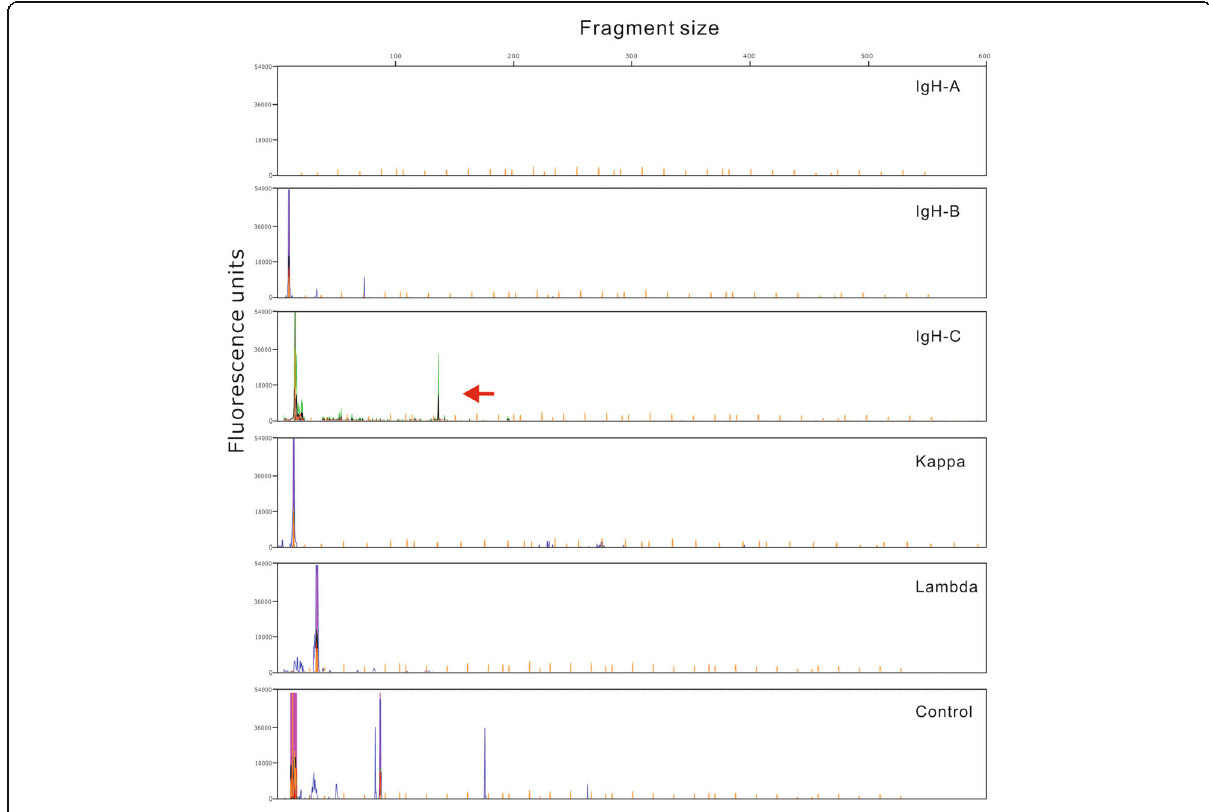
Fig. 5 Molecular testing for gene rearrangement of IgH. The tumor demonstrates a monoclonal peak for IgH-C